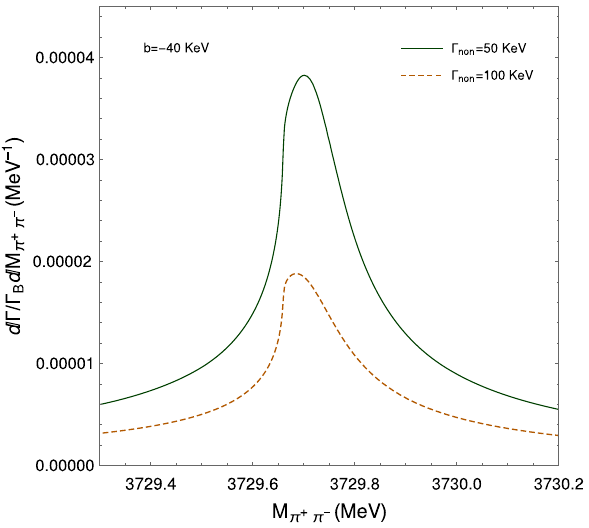
Fig. 8 d (cid:9)/((cid:9) B − dM π + π − ) for M X = 3871 . 72 ( b = − 40 KeV) and different values of (cid:9) non ( (cid:9) X = (cid:9) (cid:8)